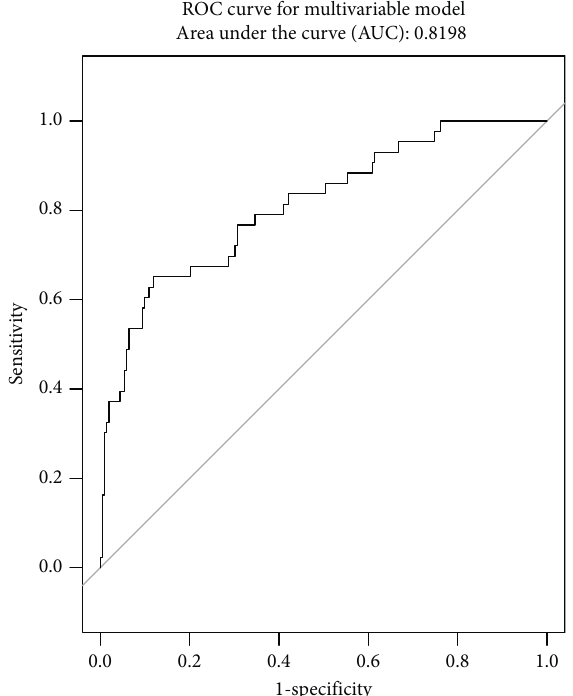
Figure 2: ROC curve for the multivariable model predicting